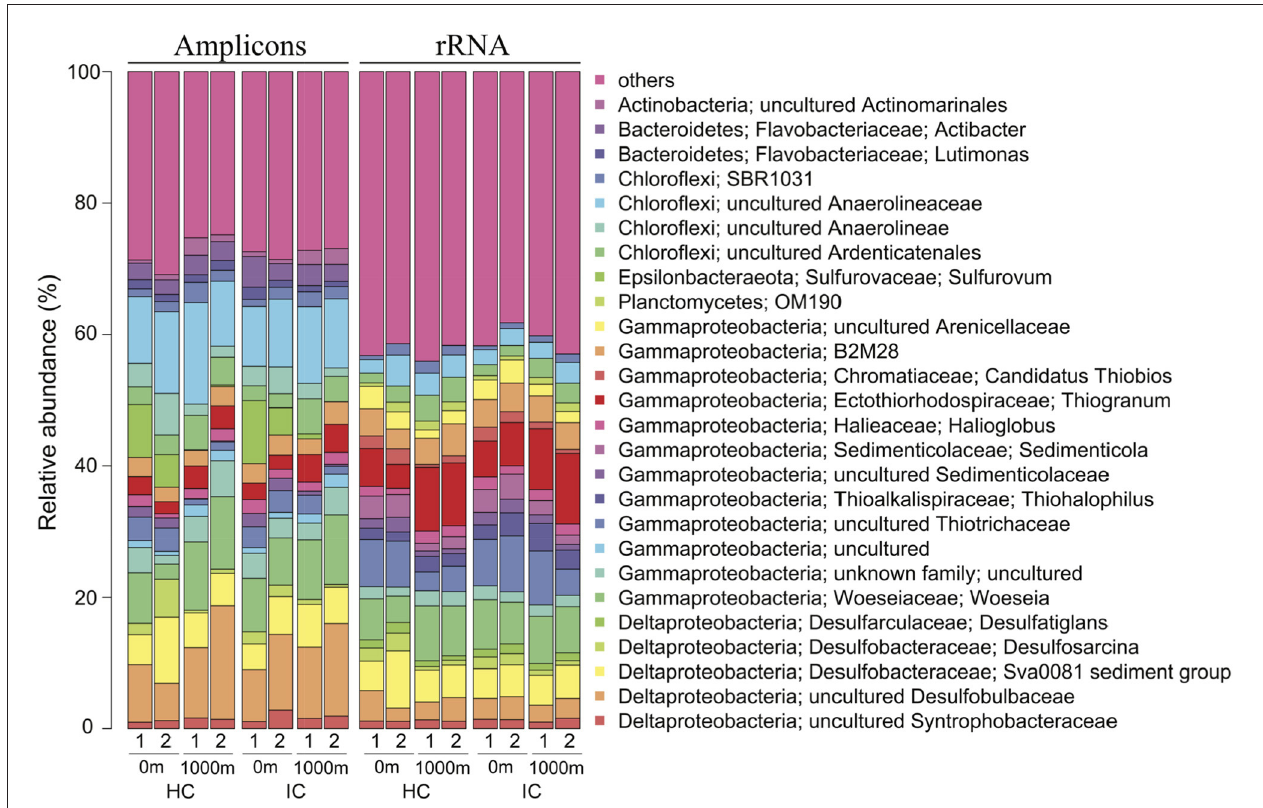
FIGURE 5 | Abundant bacterial genera in embayments. Only genera with an average abundance > 1% in the 16S rRNA gene amplicon sequencing (entire) or in the rRNA (active) dataset, respectively, are shown. Entire and active bacterial communities were assessed by barcoding and mapping of rRNA reads on denoised unique sequences, respectively. HC, Hen and Chicken Bay; IC, Iron Cove; 1, February; 2, March.